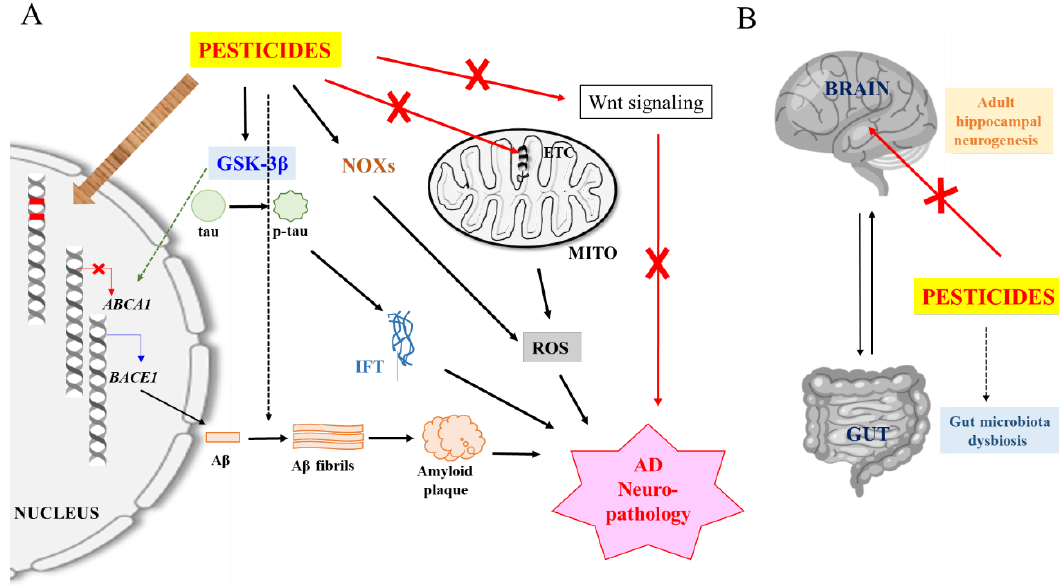
Figure 1. A schematic and generalized illustration of pesticide-induced Alzheimer’s disease (AD) neuropathology. ( A ) Pesticide inhibition of mitochondrial electron transport chain (ETC) components and activation of NADPH oxidases (NOXs) produce mitochondrial and neuron damaging reactive oxygen species (ROS). Damaged mitochondria and ROS could trigger neuroinflammation (not shown here for simplicity). Pesticide activation of glycogen synthase kinase-3β (GSK-3β) promotes β-site APP cleaving enzyme 1 (BACE1) expression and Aβ production while reducing Aβ clearance, and phosphorylates tau to promote intracellular fibrillary tangle (IFT) formation). Some pesticides may also promote Aβ fibril formation. Pesticides could inhibit Wnt signaling which is impaired in AD, and which reactivation improves AD disease phenotype. Pesticides and/or ROS could also cause DNA mutations and affect the expression of AD-related genes via epigenetic mechanisms. ( B ) Pesticides could inhibit hippocampal adult neurogenesis and affect AD pathology via gut microbiota dysbiosis. See text for more details.